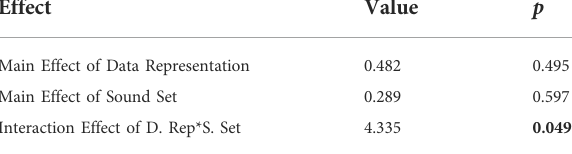
TABLE 8 Statistical analysis of NTLX data.